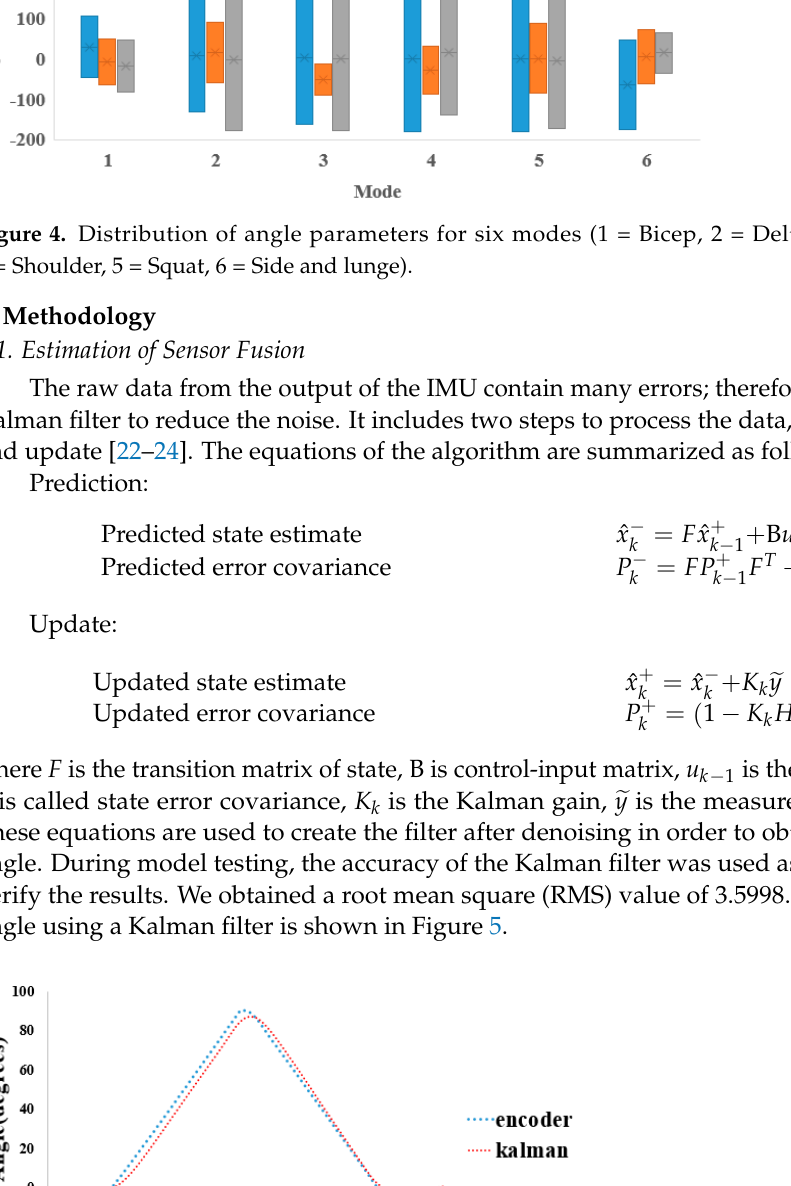
Figure 6. Signal from the IMU sensor working on two cycles. First, Section I denotes the period at the beginning of the exercise with no movement. Section II denotes the period during which one cycle (or repetition) of exercise is per- formed in the biceps’ mode. Third, Section III denotes the short time of rest before execu- tion of the next repetition in Section IV. Finally, Section V denotes the completion of the exercise. The dumbbell is not moved at the beginning (I) and the end (III, V) of the exercise, and only the gravitational force acts on the sensor (mostly on the Y -axis (a-Y)). We can also see the corresponding angular velocity profiles ( ω -X, ω -Y, ω -Z). The movement con- tains a steady rotation around the Z -axis (yaw ( ψ )). Then, we can detect the cycle of exercise, which is the duration of movement to finish one repetition using the gyroscope sensor and the angle between the forearm and the up- per arm. As all actions of the mode using dumbbells require time to stop the movement to transform the direction, it is a period of time to make the signal from the gyroscope sensor reach zero. In addition, we need to combine the angle (yaw angle in biceps’ mode)